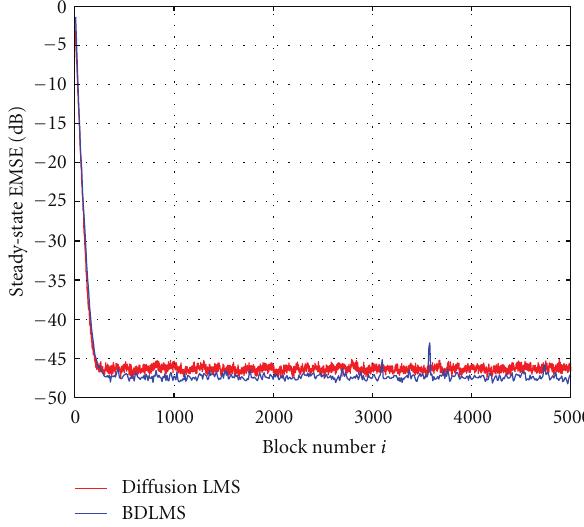
Figure 3: Global mean-square deviation (MSD) curve for di ff usion and block di ff usion LMS.